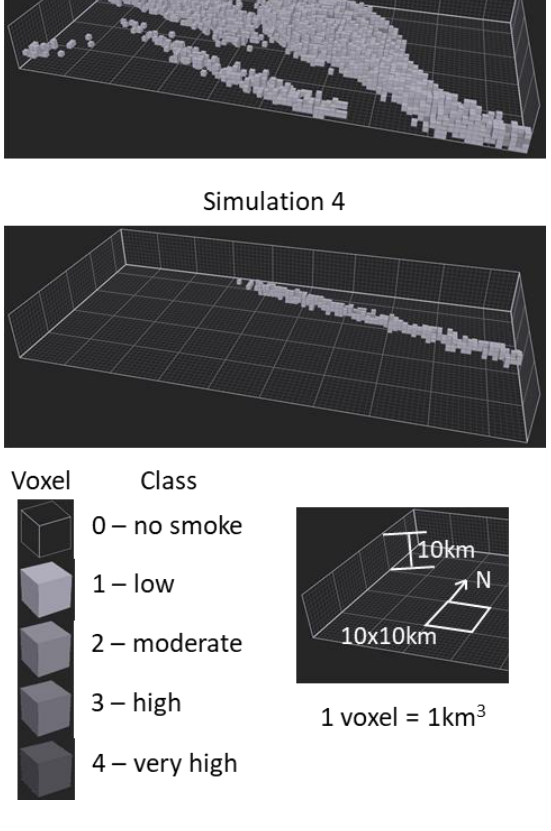
Table 1 . Values obtained for 3D Accuracy and 3D Kappa Figure 2 . Agent-based model forest-fire smoke propagation simulation outcomes in voxel data format used for six comparisons.